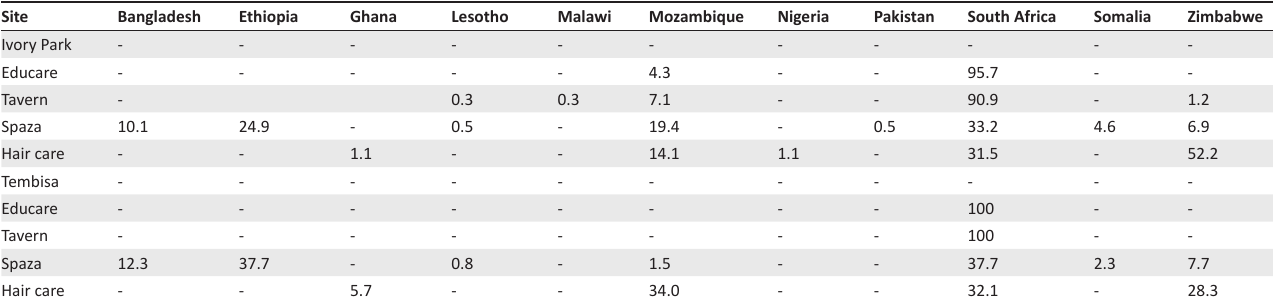
TABLE 4: Business ownership and/or county of nationality ( % of enterprise category). Site